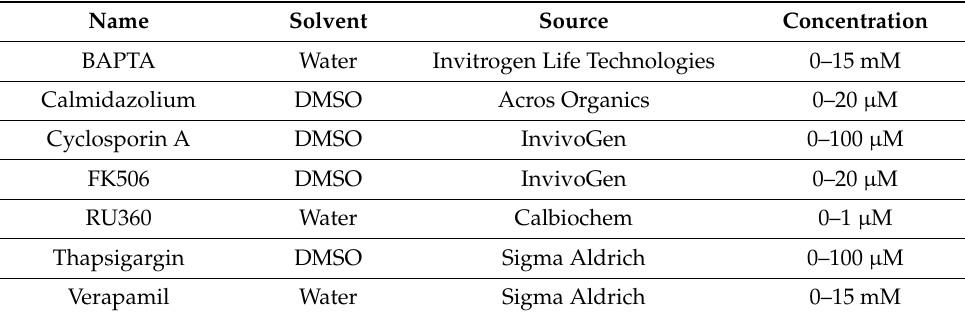
Table 1. Pharmacological agents used to inhibit Ca 2+ signalling in F. oxysporum